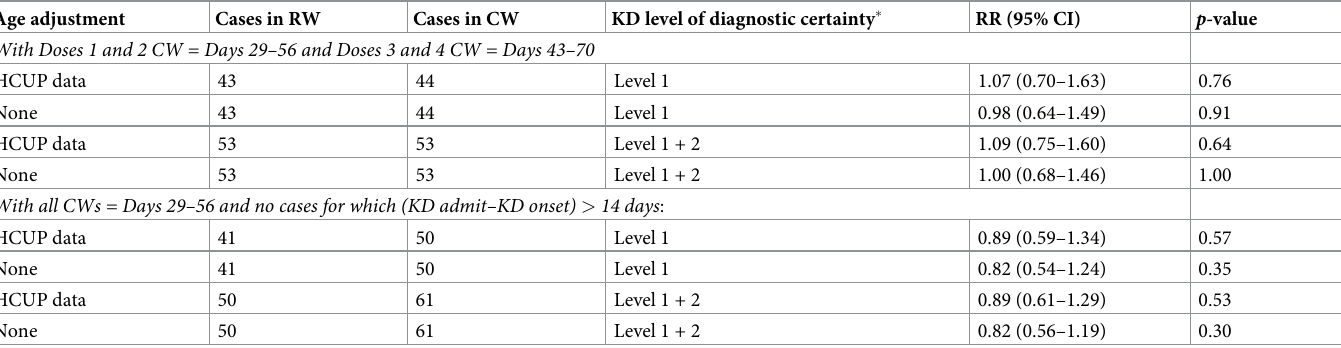
Table 2. Results of SCRI